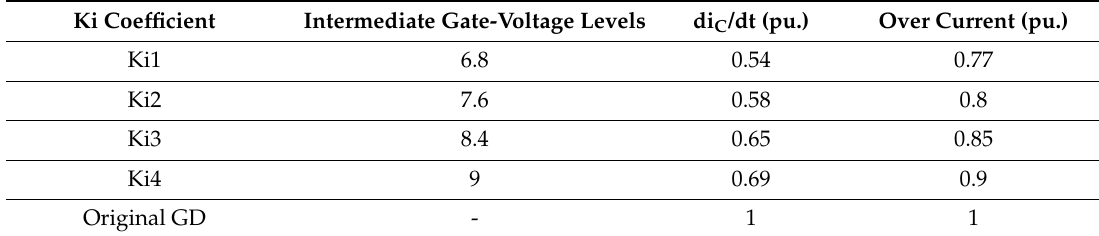
Figure 4. ( a ) The collector current waveform, performed by the original gate driver. ( b ) The zoomed view to show the performance of the Active Gate Driver (AGD) with different Ki coefficient and its effect on the current at turn-on. Table 1. Collector current trajectory controlled by closed-loop GD with different Ki coefficients.